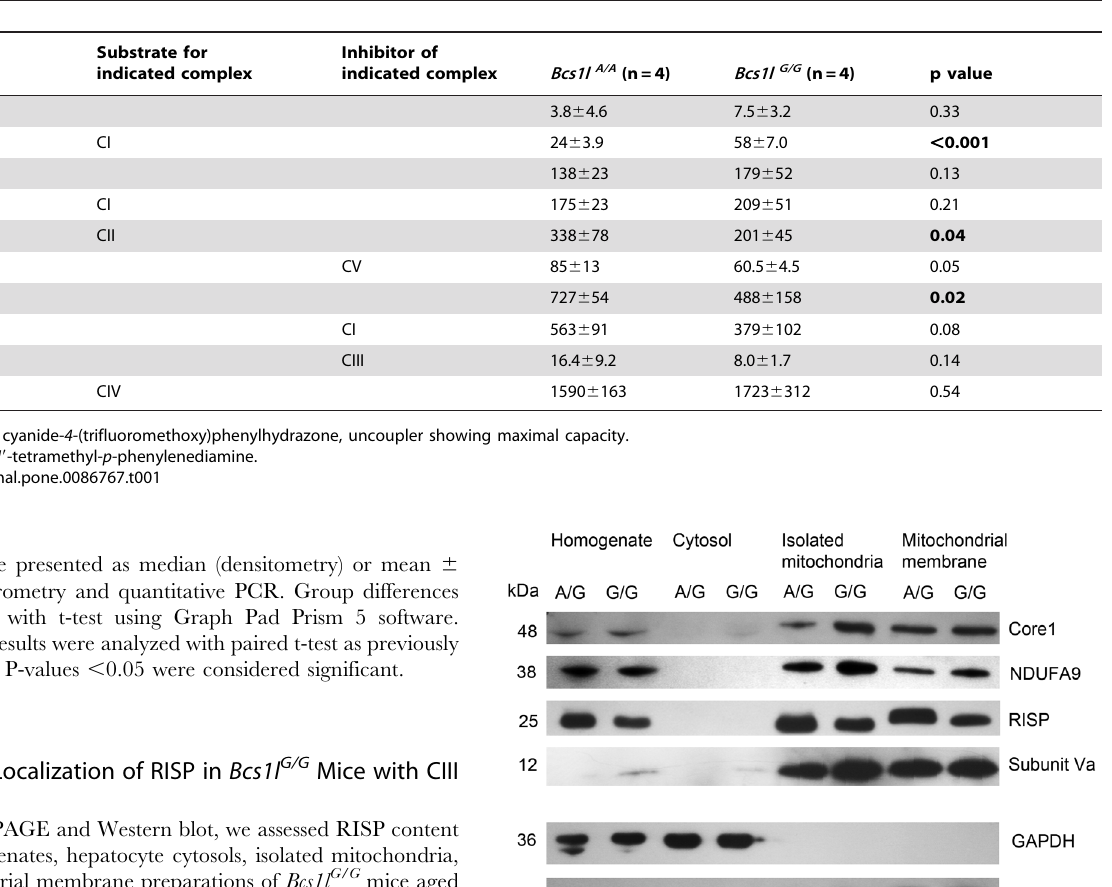
Table 1. Respiratory chain function, measured as oxygen consumption (O 2 flux/pmol/(s x mg), mean 6 SEM) with high resolution respirometry on isolated liver mitochondria using SUIT protocol [19] with sequential addition of substrates, ADP, and inhibitors, showed significant changes in sick 27–29 days Bcs1l G/G animals compared to control animals ( Bcs1l A/A ).